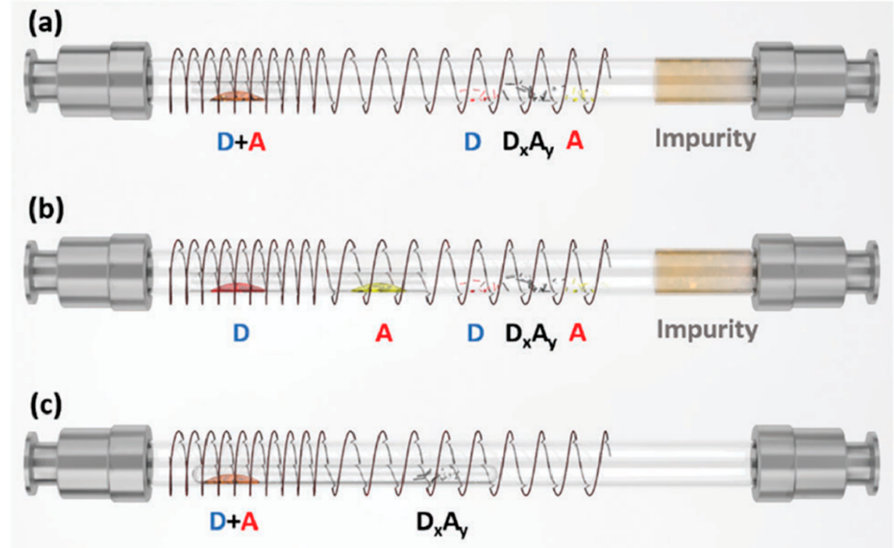
Figure 5. Schematic for the single-crystal growth of organic charge-transfer cocrystals by the gas-phase methods: ( a ) Open system (mixed starting materials); ( b ) Open system (separated starting materials); ( c ) Close-system. ‘‘D’’ means donors. ‘‘A’’ means acceptors. ‘‘D + A’’ means the mixture of donors and acceptors. D X A Y means an organic charge-transfer cocrystal with the stoichiometry of X:Y. Data are reproduced with permission from [6].